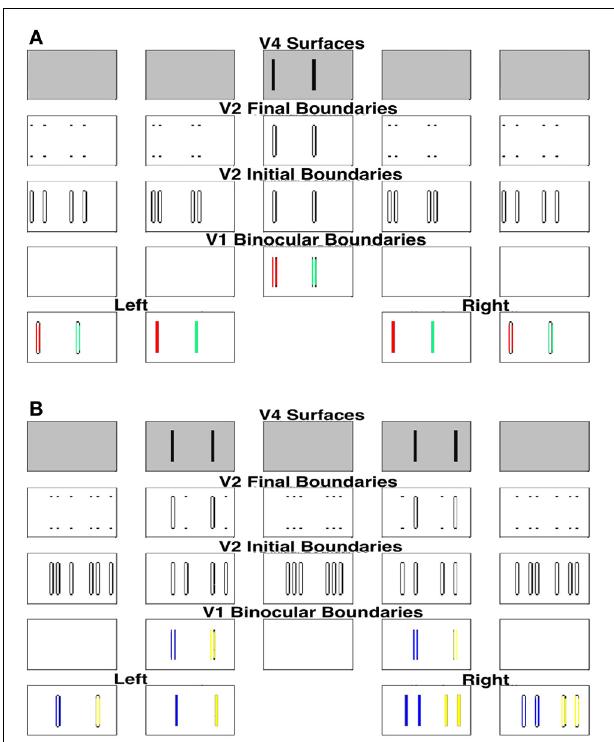
FIGURE 9 | Explanation of the simulation of components of the Venetian blind effect where the binocular fused bars are marked in the same color. (A) Processing of image components in retinal correspondence. (B) Processing of image components that are disparate in the two eyes.